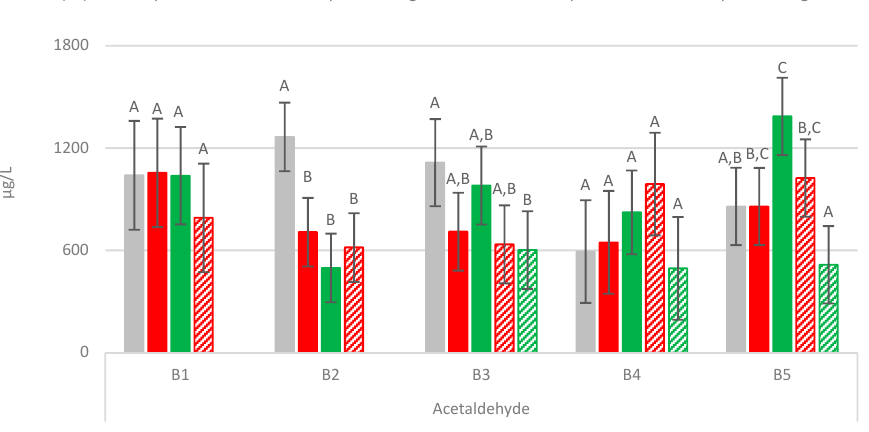
Figure 5. Evolution of acetaldehyde under the simulated conditions. A Tukey test was performed for each batch. Different letters represent statistically significant differences ( p < 0.05).